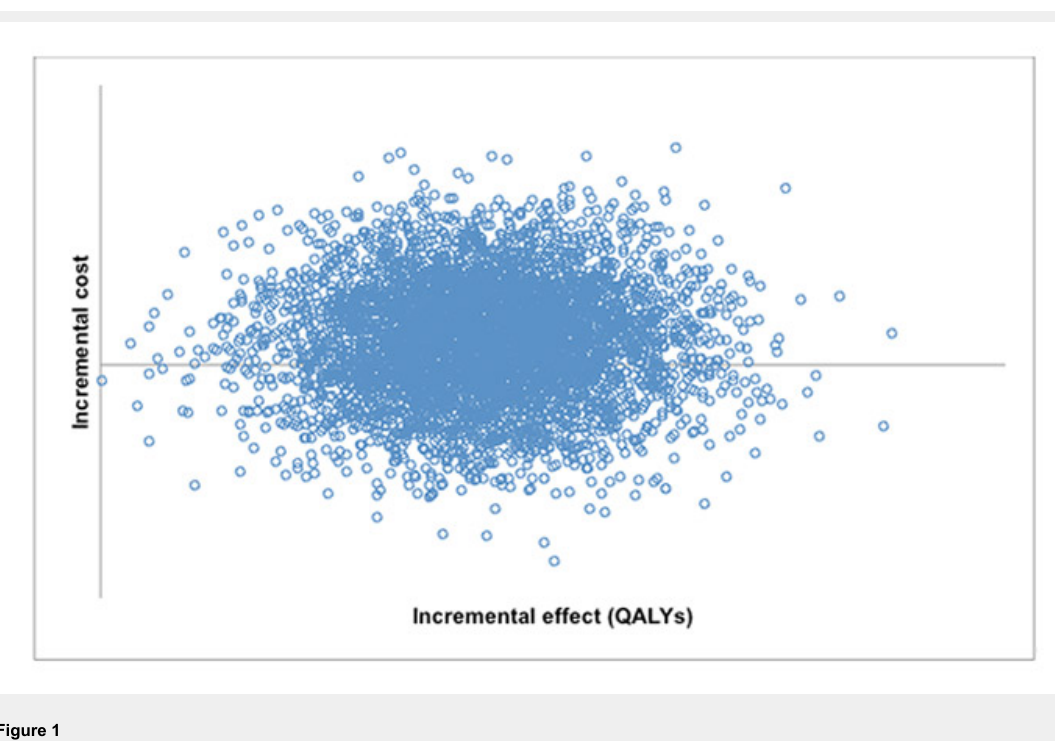
Results of the probabilistic sensitivity analysis. Incremental costs and effects are calculated as ticagrelor minus generic clopidogrel.